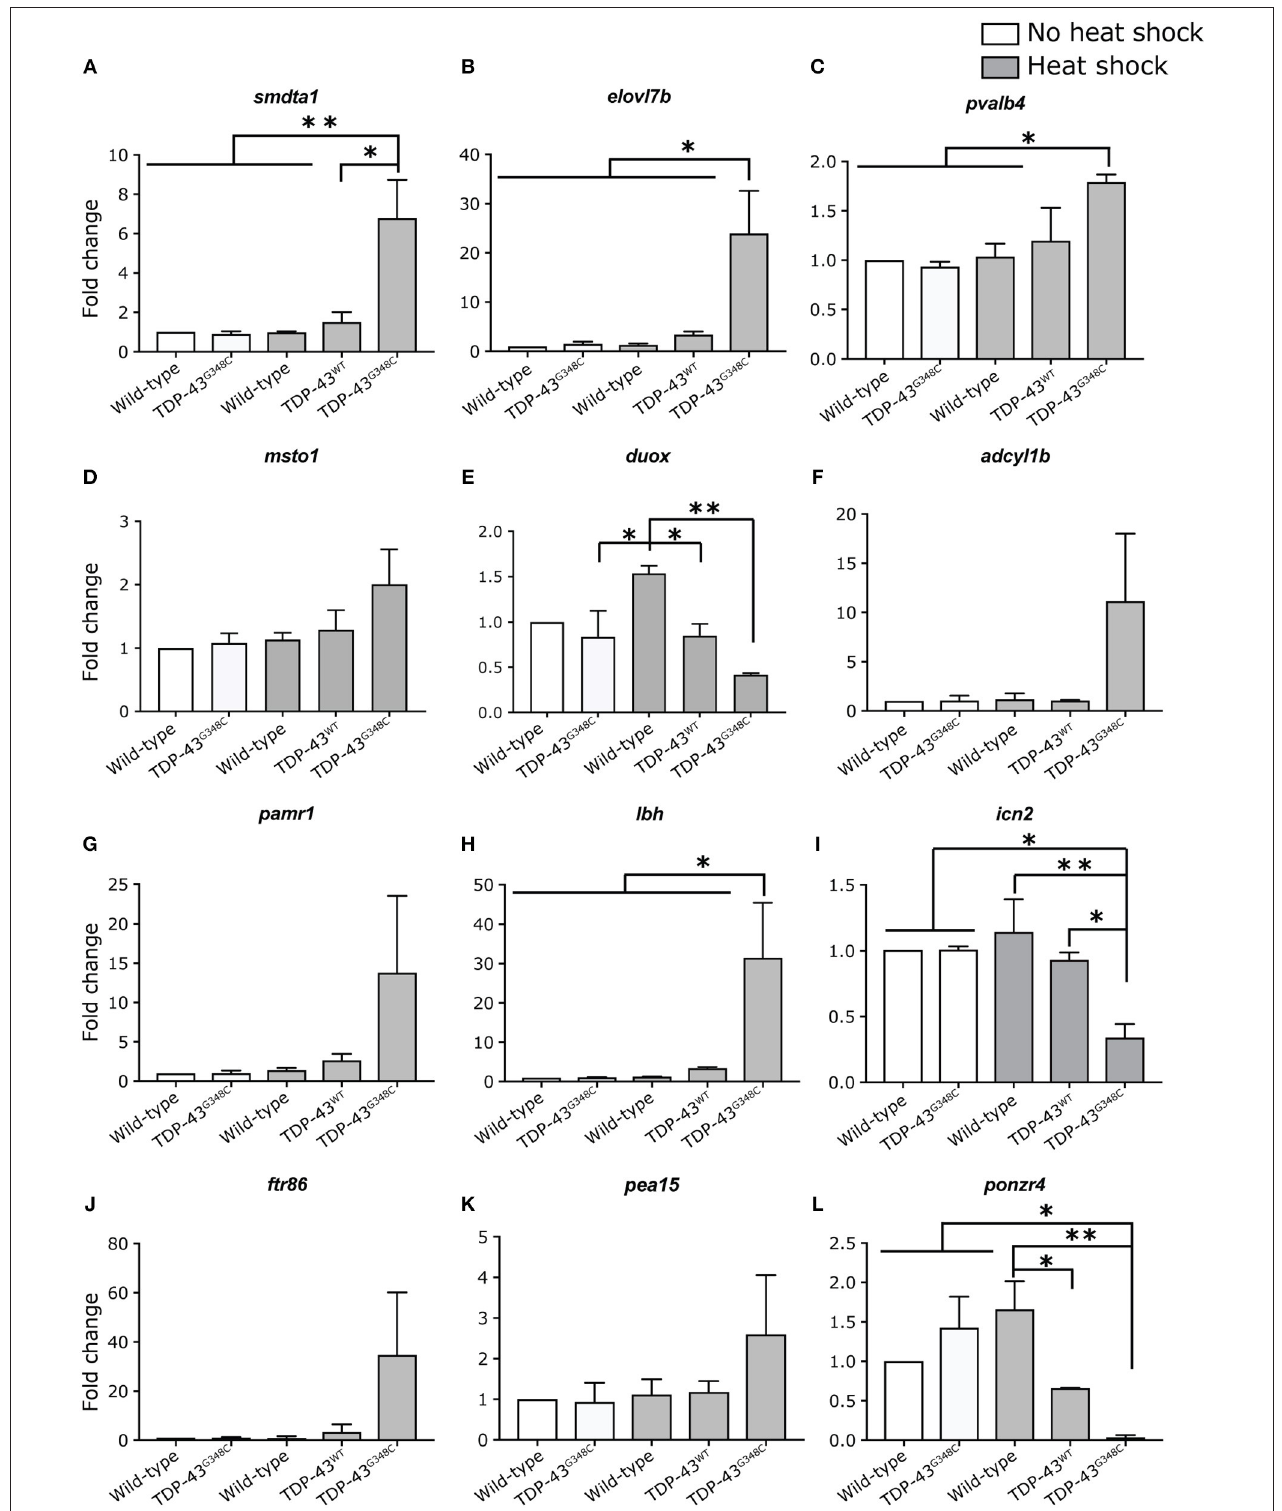
FIGURE 5 | Validation of differentially expressed genes by RT-qPCR. (A–L) Expression level of 12 selected genes was tested in duplicate by RT-qPCR in all of the conditions. One-way ANOVA with Tukey’s multiple comparisons test was performed. * p -value < 0.05, ** p -value < 0.01 and error bars are standard deviation.